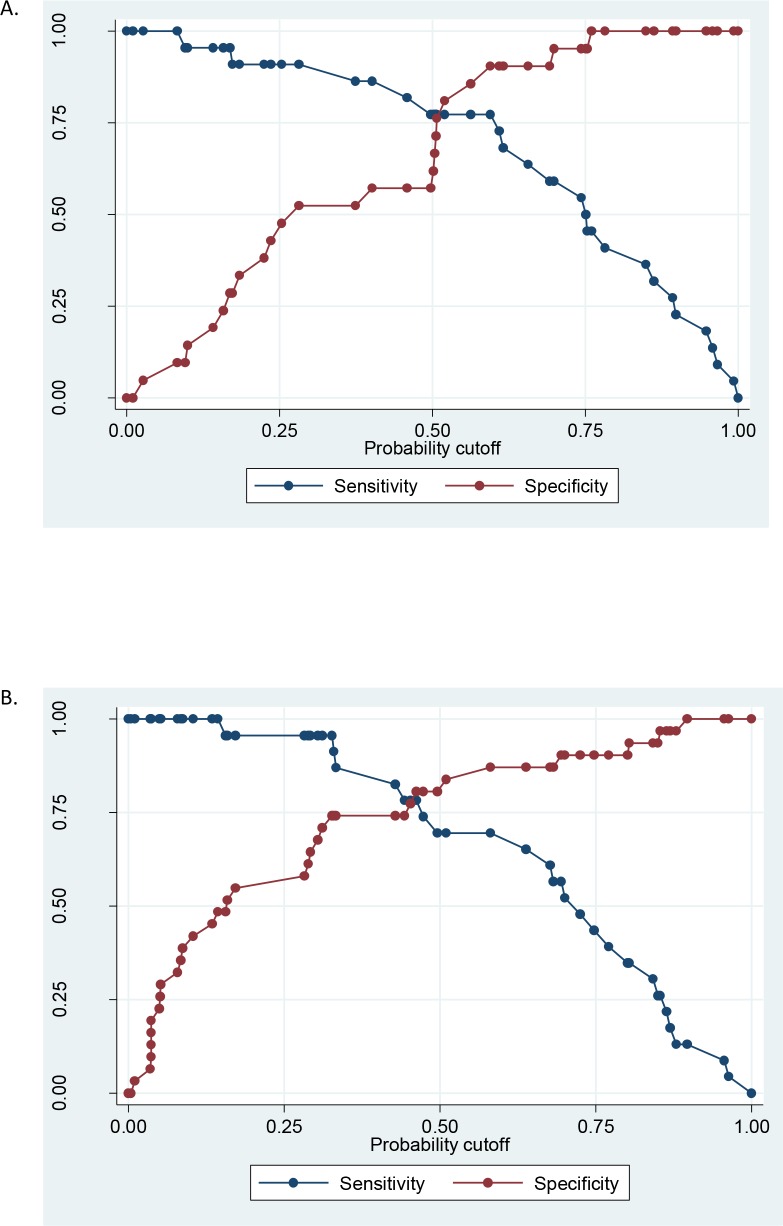
Sensitivity and specificity plots of Model 13 (A) and Model 14 (B) with the varying probability cut-offs using the discovery cohort. The y-axis shows the true positive rate (sensitivity in blue) and the true negative rate (specificity in red) of the model’s capability at different probability cutoff on the x-axis. The probability cutoff range (x-axis) allows the investigators to choose how sensitive and specific they want the model to be at different setting depending on the aim of the models.